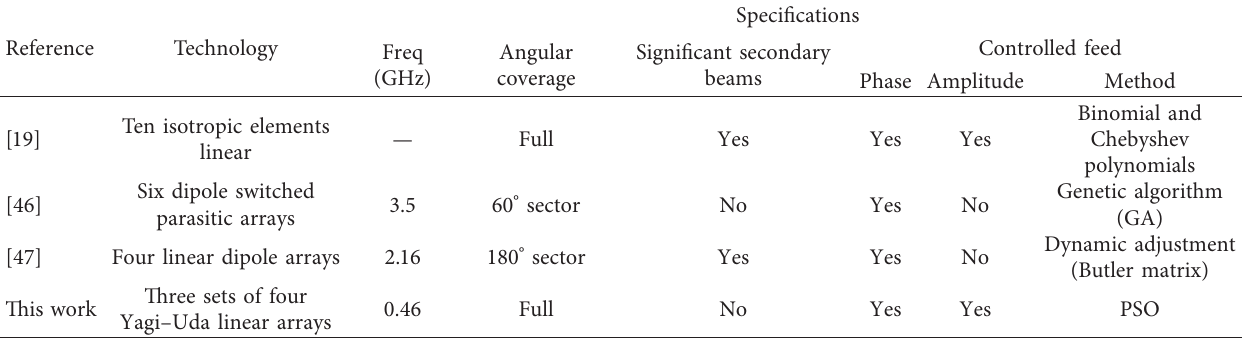
Table 1: Comparison between smart antenna